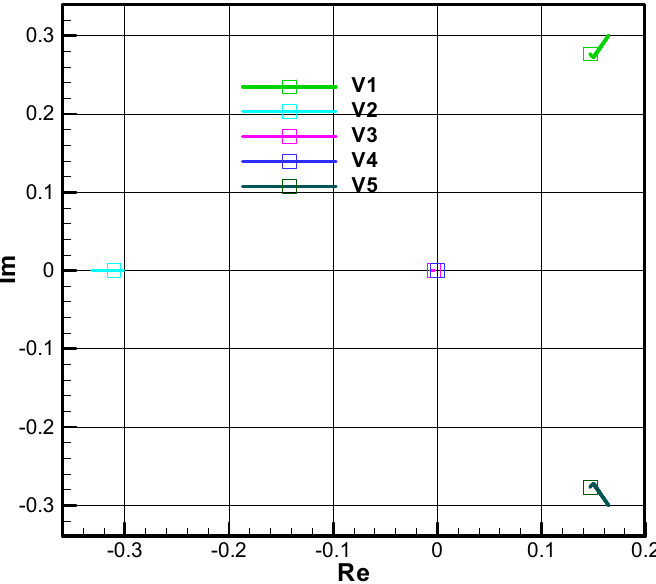
Figure 17. Eigenvalues of the stability matrix A for longitudinal motion in horizontal evolution.